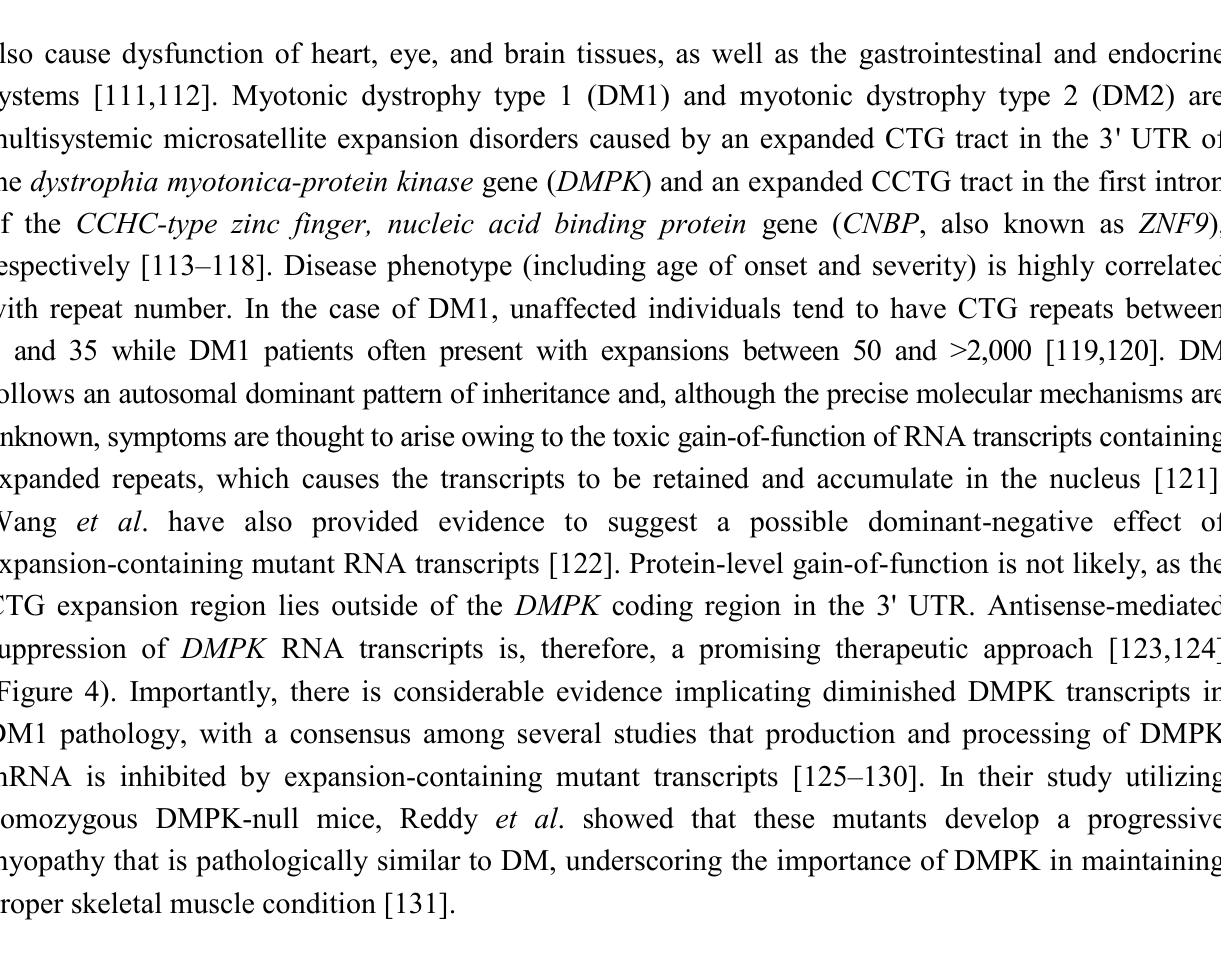
Figure 4. Mechanism of antisense silencing via RNase H1 activity. Myotonic